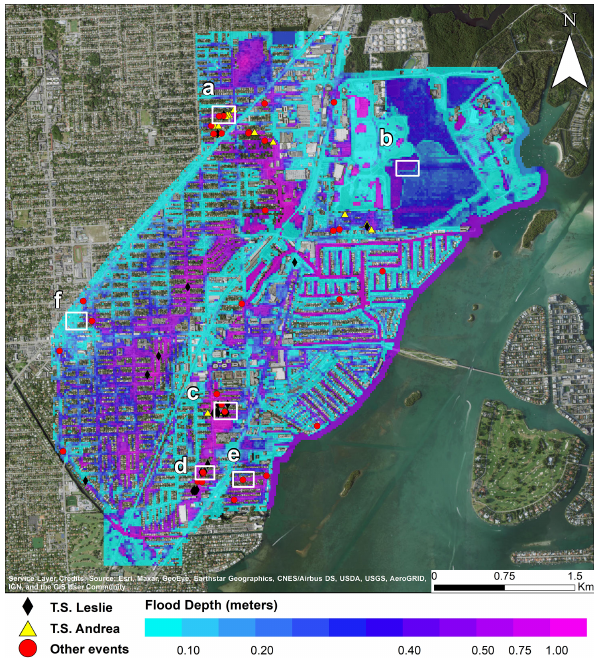
Figure 11. Distribution of maximum flood depths for Tropical Storm Leslie. The markers indicate repetitive loss properties caused by Tropical Storm Leslie (black), Tropical Storm Andrea (yellow) or other storm events (red). Maximum flood depths at six sample locations (white) are presented in Fig. 11. Table 2. Quantitative analysis of simulated flood depths with re- spect to FEMA’s repetitive loss properties database by